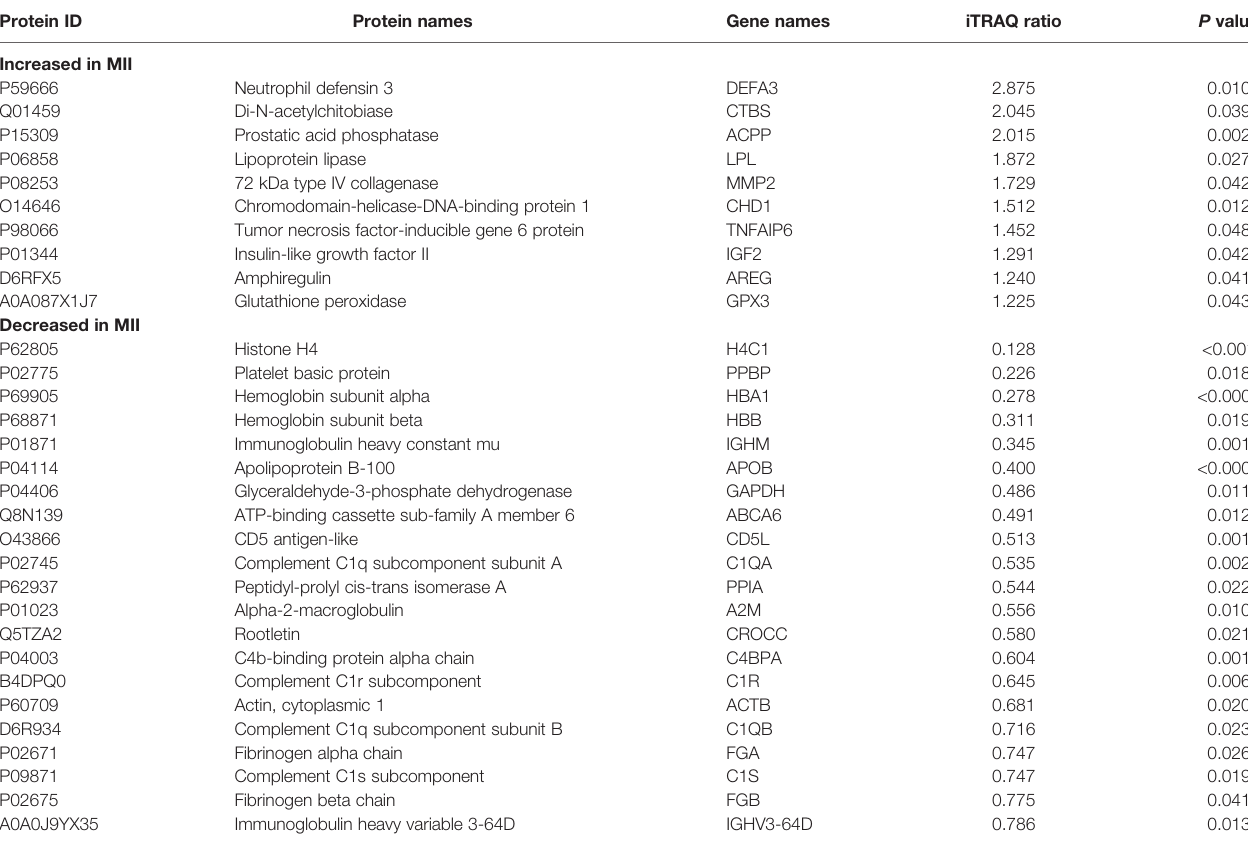
TABLE 1 | Differentially expressed proteins and their expression levels quanti fi ed by iTRAQ-2DLC-MS/MS. Protein ID Protein